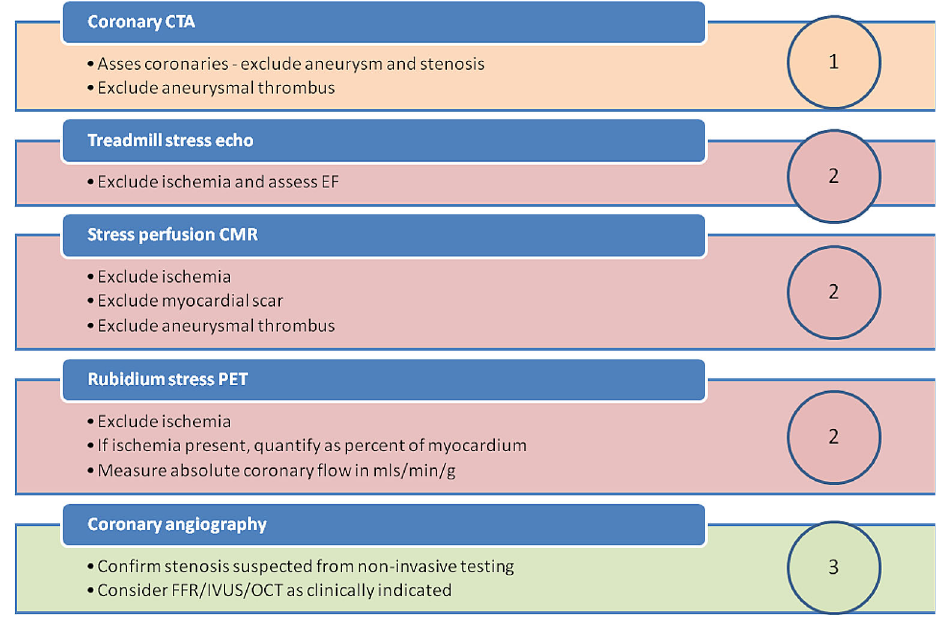
Figure 12. A hierarchical approach to testing in complicated adult Kawasaki disease. Newly referred adults - withahistoryofKawasakidiseaseinchildhood-arestagedwithupto3levelsofinvestigation. Level1: CoronaryCTA is performed first. If there is no evidence of coronary involvement (or no worse than only mild dilatation), no further investigation isrequired. If there isevidence ofaneurysm or stenosis further testing is required. Level 2: Theprecise test chosen should depend upon availability and local expertise. If embolic infarction from aneurysmal thrombus issuspected,thenCMRisoftenthemostrevealingtest.Wheretheselectedlevel2testisequivocal,weoftenproceed to an alternative level 2 test for confirmation. When there remains residual doubt, or if a level 2 test is positive, we proceed to the next step. Level 3: Invasive coronary angiography with or without hemodynamic assessment of severity of stenosis by FFR. While OCT and IVUS may be useful to assess stent deployment, percutaneous coronary interventionisoftenapoorerchoicethanbypasssurgeryforthemajorityofKawasakipatients,giventhevariabilityin cross-sectional diameter of involved